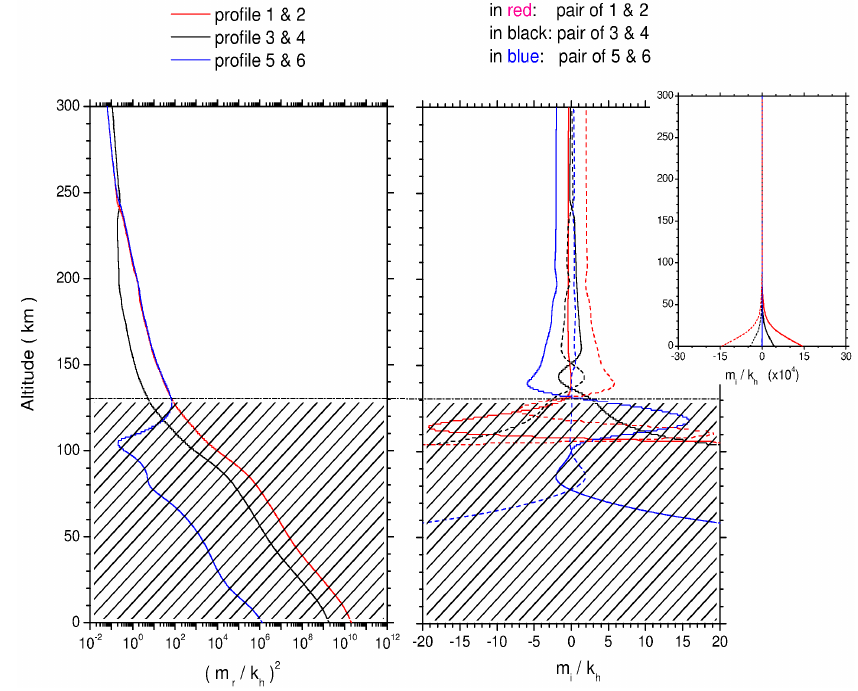
Figure 6. Six extraordinary dissipation wave modes out of the eight complex solutions of the Z 8 -dispersion equation, Equation